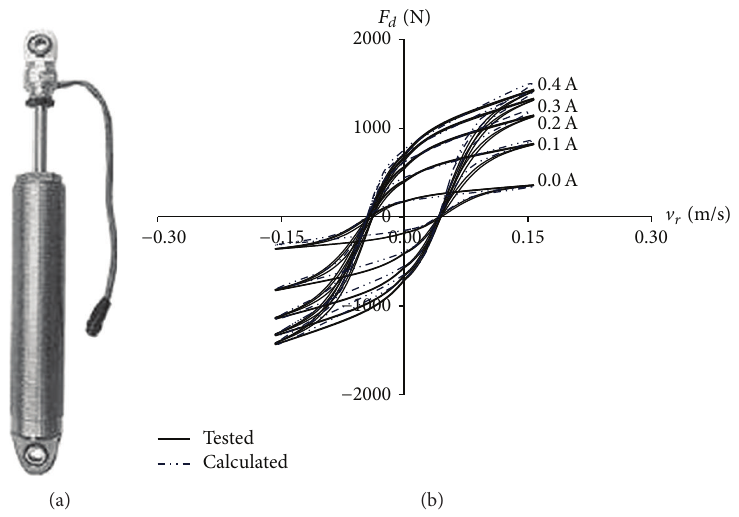
Figure 3: (a) A pictorial view of the candidate MRD. (b) Comparison of tested and calculated